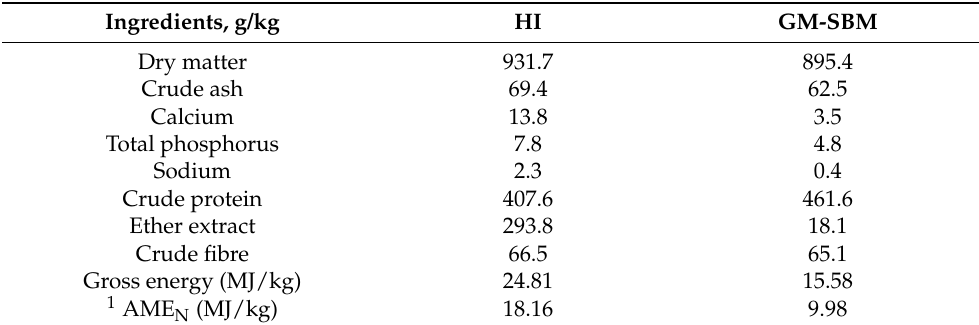
Table 1. Chemical composition and energy value of full-fat Hermetia illucens meal (HI) and genetically modified soybean meal